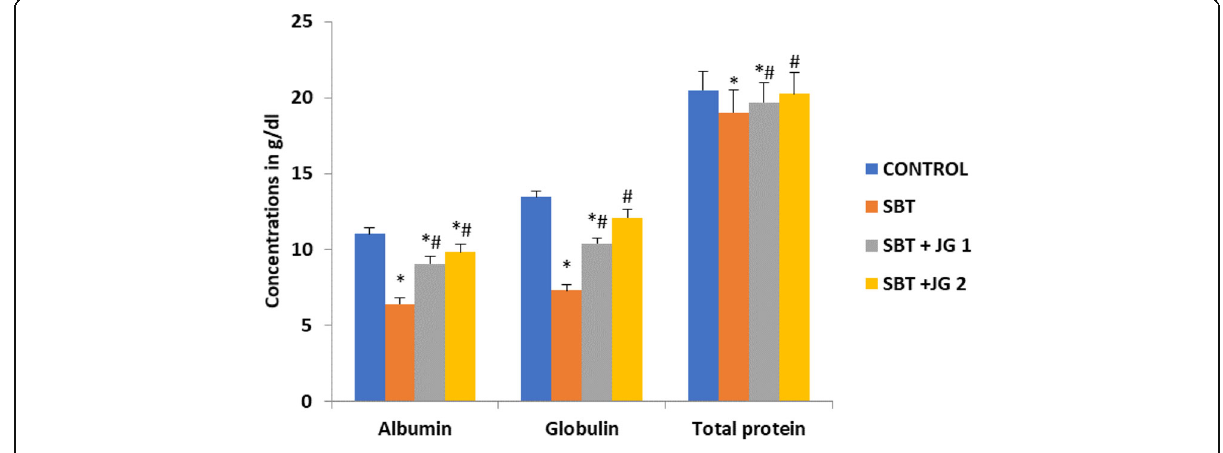
Fig. 4 The effect of methanolic leaf extract of Jatropha tanjorensis on sodium benzoate mediated alteration in serum protein levels in experimental rats. Data presented as Mean ± standard deviation ( n = 6). * Significantly different from normal control group at P < 0.05, # significantly different from group SBT at P < 0.05. Control: Animals were given distilled water only; SBT: Animals were treated with oral administration of sodium benzoate (200 mg/kg bw) only; SBT + JG1: Animals were given sodium benzoate (200 mg/kg bw) + J. tanjorensis extract (200 mg/kg b.w); and SBT + JG2: Animals were given sodium benzoate (200 mg/kg bw) + J. tanjorensis extract (500 mg/kg